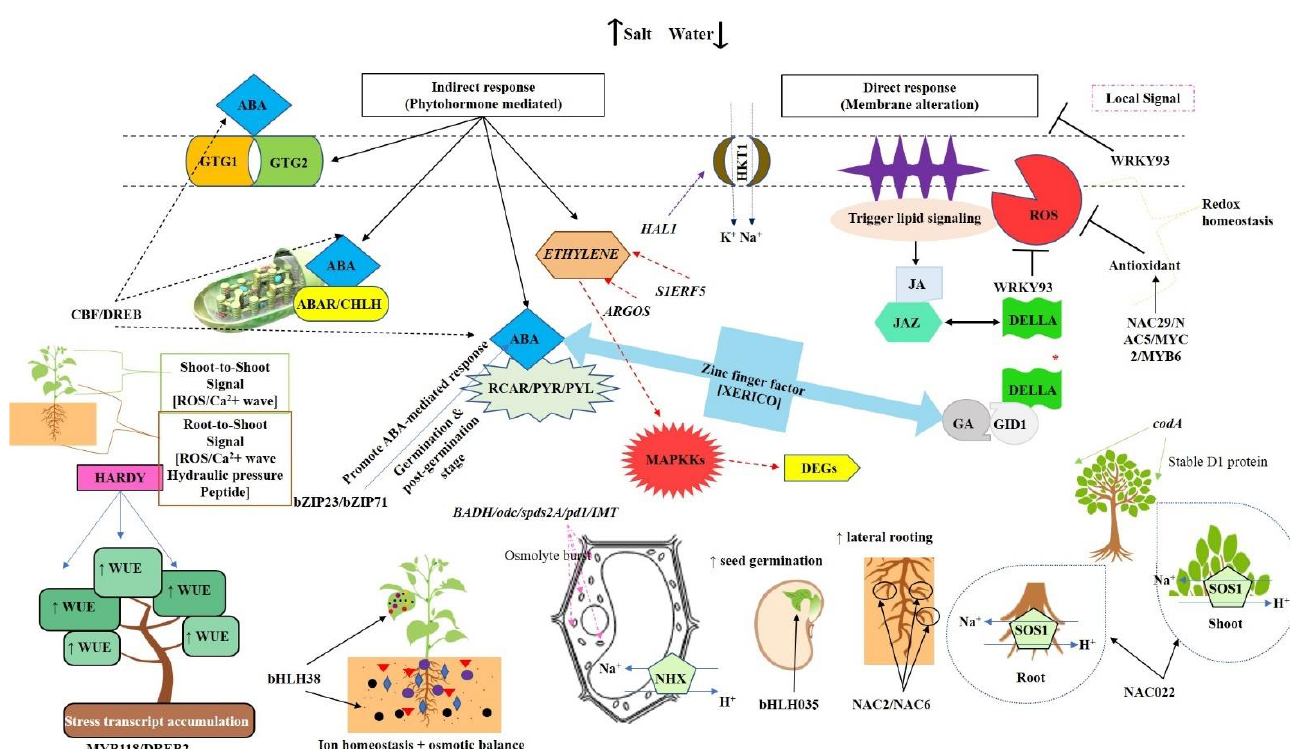
Figure 3. Schematic representation of the molecular mechanism for combined drought and salt stress endorsement in crop plants. ↓ & ↑ indicate salt and drought stress, respectively.